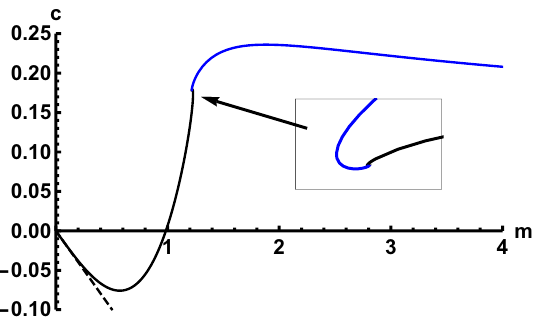
Figure 1 . In this (cid:12)gure we plot the condensate parameter c versus the mass parameter m . The solid curves have been found numerically both for black hole embeddings (black curve) and Minkowski embeddings (blue curve). The transition between them occurs at m (cid:25) 1 : 23. The condensate c vanishes for a black hole embedding at approximately m (cid:25) 0 : 985. The dashed linear curve near m = 0 corresponds to the high temperature analytic result (E.22). The condensate of the Minkowski embeddings with m ! 1 tends to zero as c / m (cid:0) 14 3